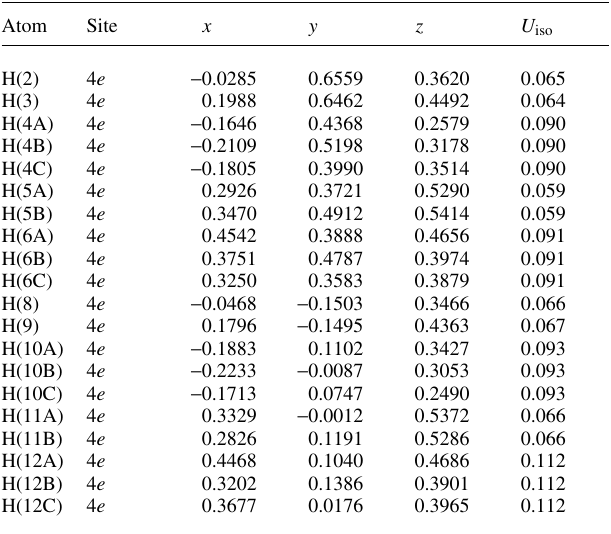
Table 2. Atomic coordinates and displacement parameters (in Å 2 )